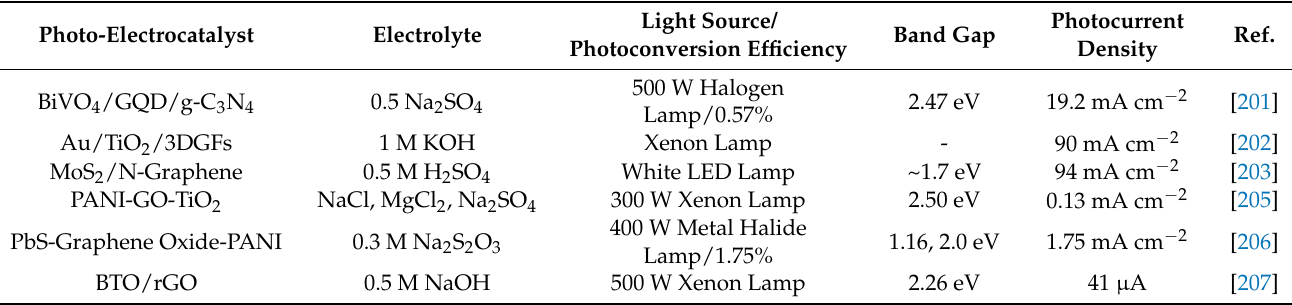
Figure 21. ( a ) Schematic illustration for PCHER and PECHER systems. ( b ) Open-circuit potential (OCP) versus time under on/off of visible light irradiation with interval 50 s. ( c ) The linear sweep voltammograms of the photocatalysts under visible light irradiation. (Reprinted with permission from reference [209]. Copyright 2019, Elsevier). Table 5. Summary of PEC activity by graphene and its derivative